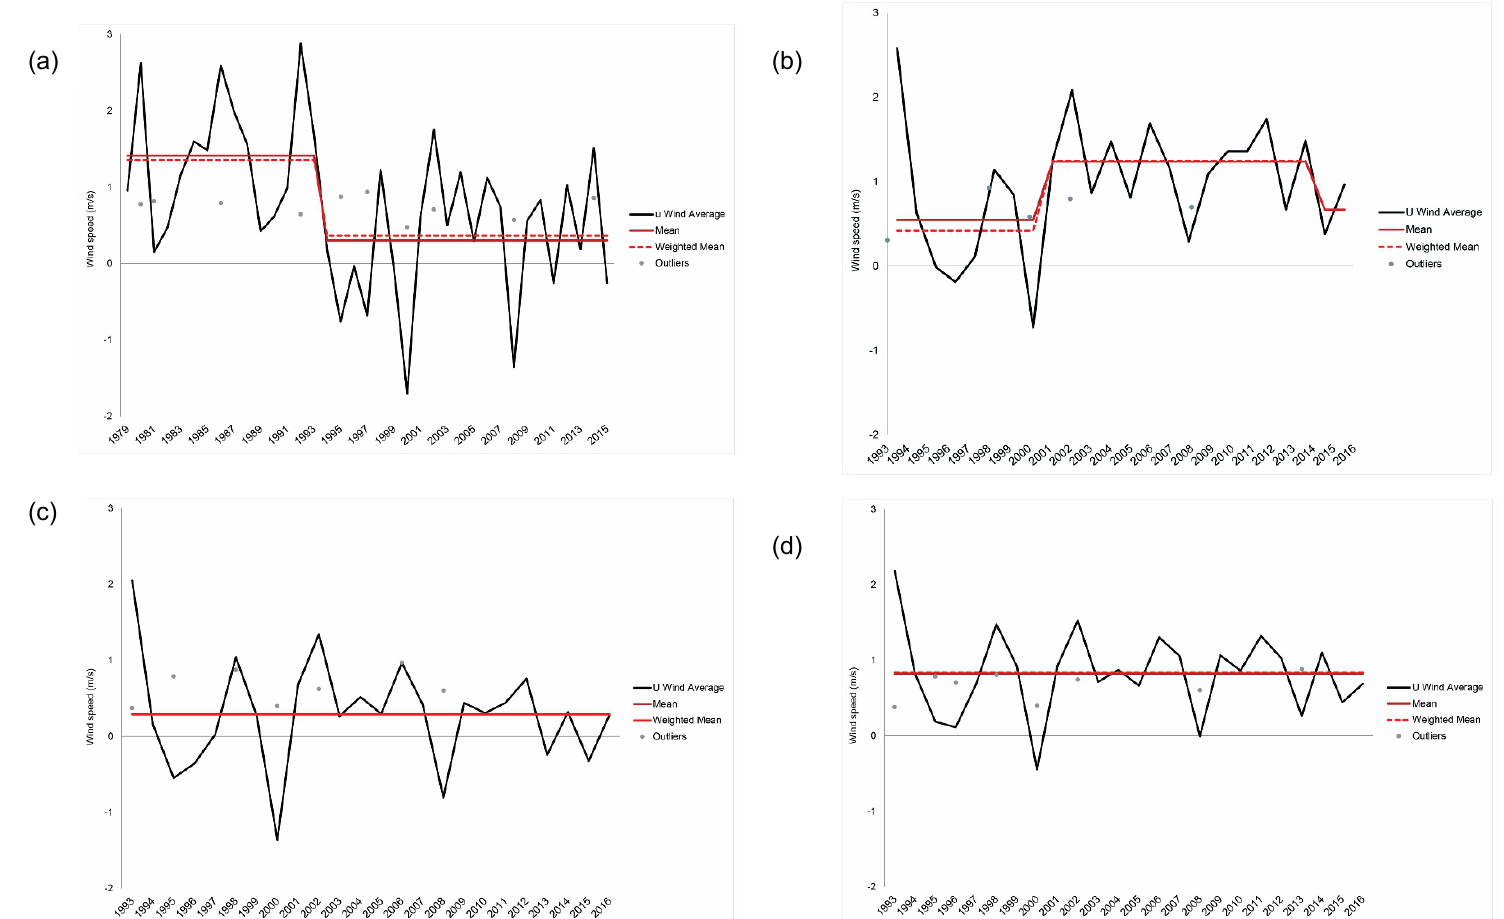
F igure A5.3: Autumn mean values for U component of wind speed for (a) NCEP-DOE, (b) scatterometer aggregate, (c) Witsand and (d) Mossel